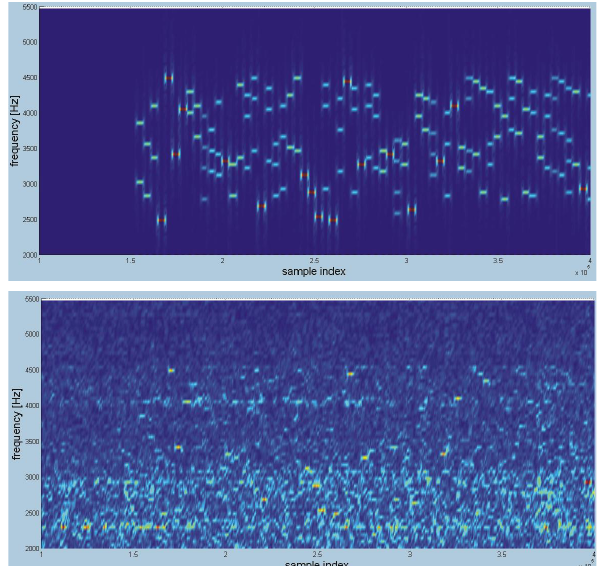
Fig. 4. Spectrograms of transmitted (electrical output, top) and re- ceived (acoustic in-water, bottom) signals of a of HAM.node mo- dem in incoherent frequency shift keying (hopping n-of-m-FSK) modulation mode. The record was taken in 2007 during tests in the Bergen Fjord across at least 500m of horizontal transmission distance with the transmitter at 20m and the receiver at 10m depth. The x-axis shows sample number (linearly related to time), the y- axis the signal frequency in Hz. Colour indicates spectral intensity (blue=low to red=high).